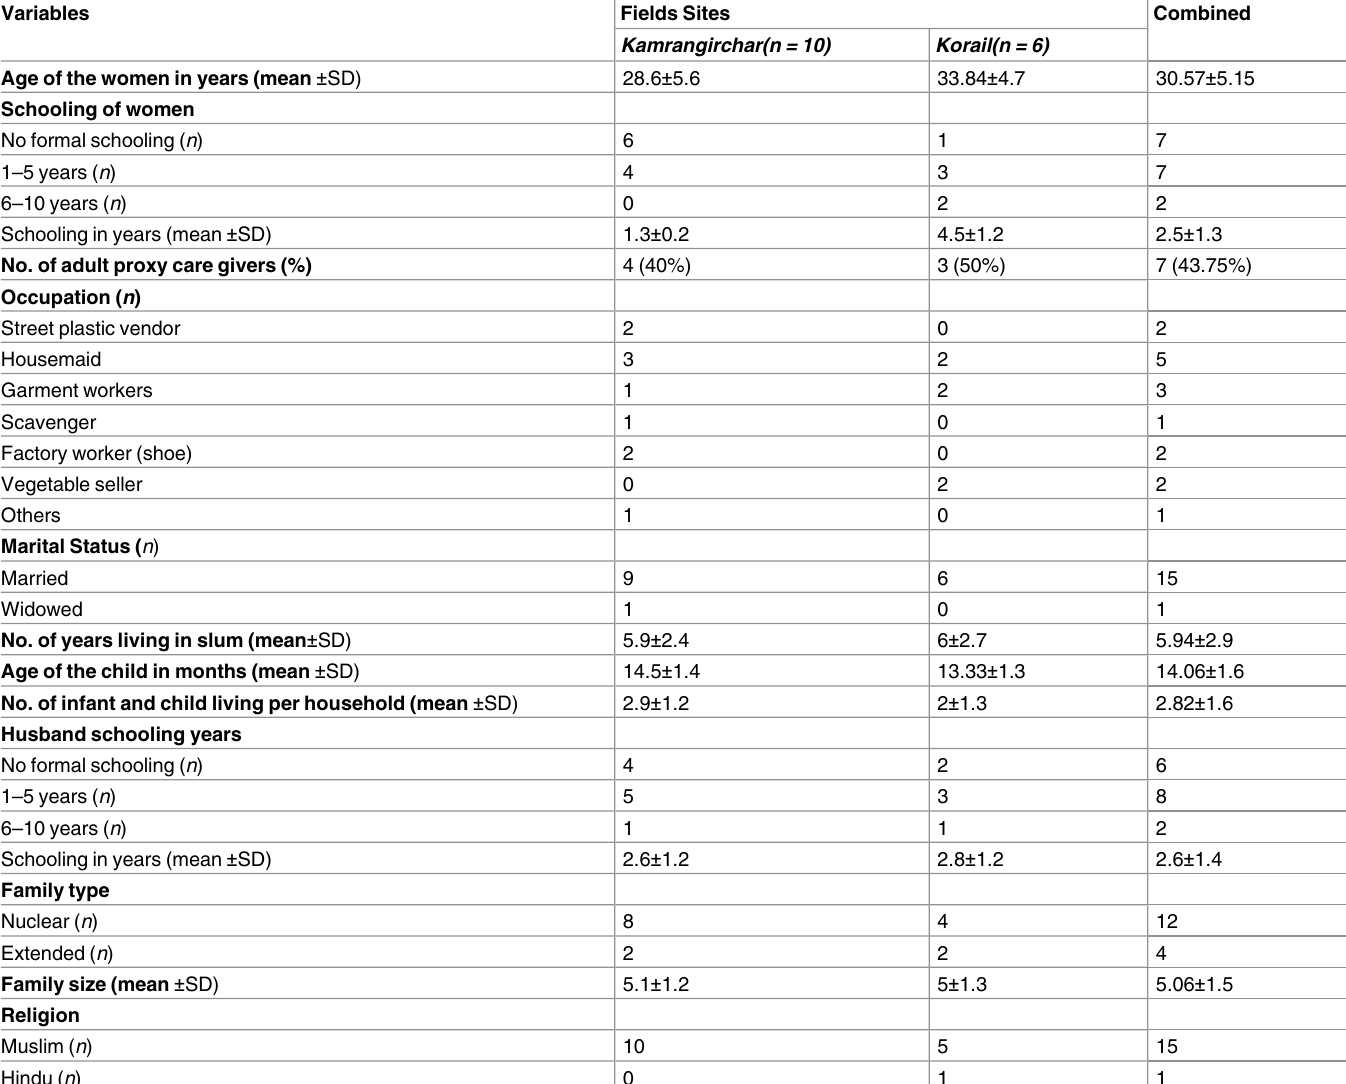
Table 2. Socio-demographic characteristics of the participant (IDI: n =